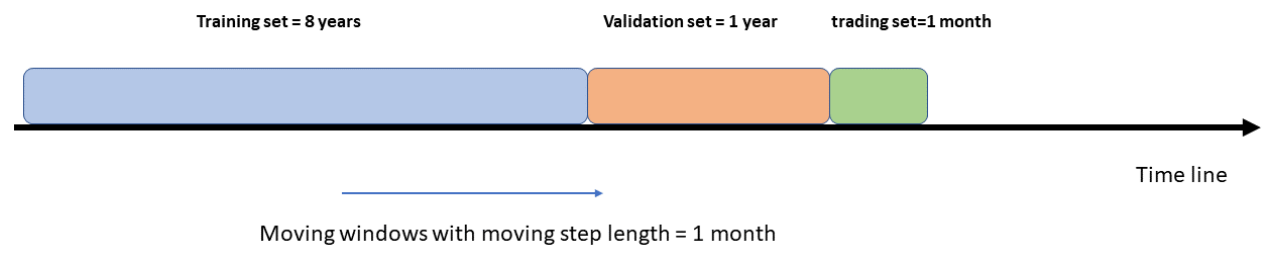
Figure 3. Data division and rolling (we used 20 trading days as 1